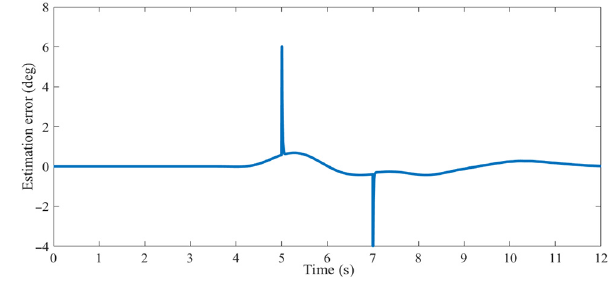
Figure 10 Results of simultaneous gain-stuck detection of two sensors